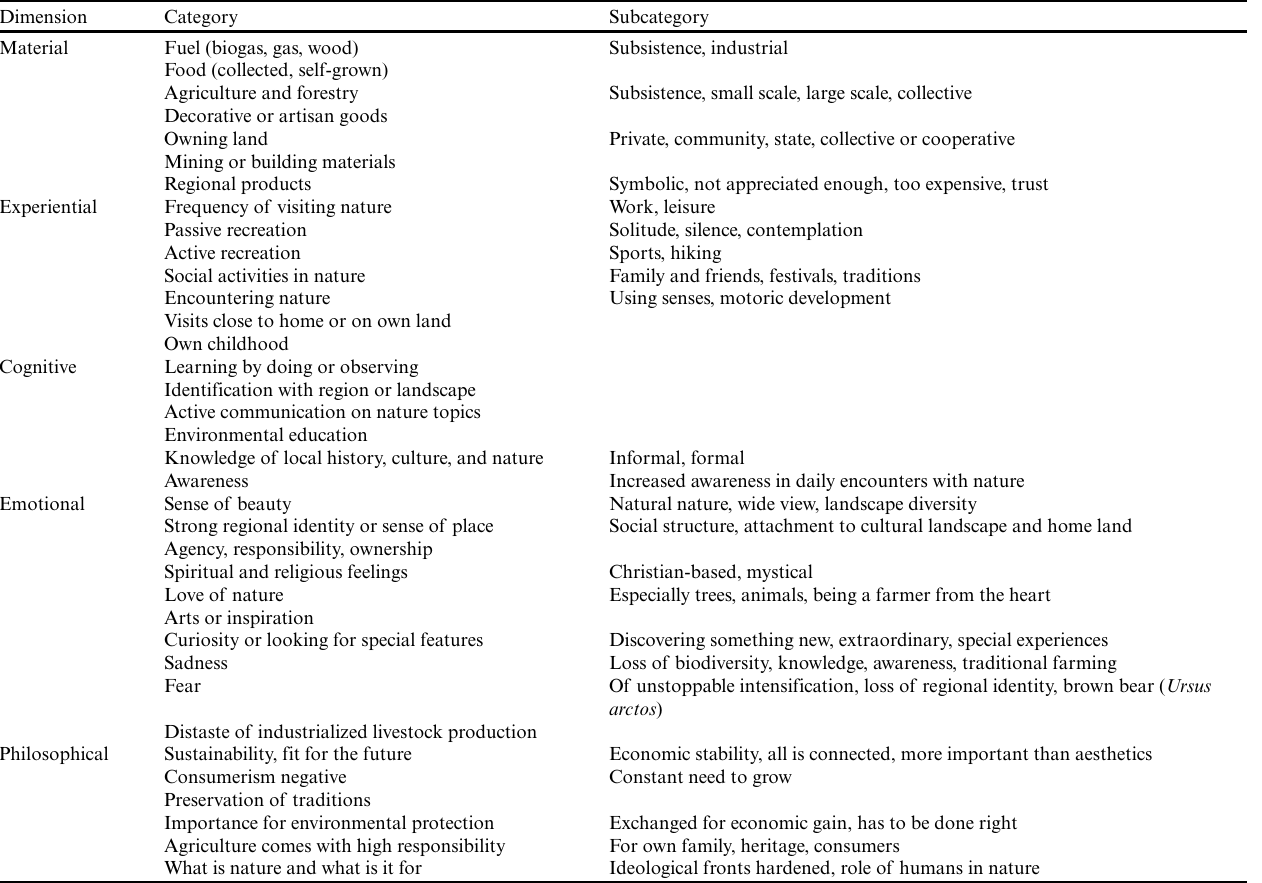
Table 1. Results of the cross-country, summarizing content analysis, grouped into five dimensions of human–nature connectedness. Categories and subcategories are themes that emerged from the interview